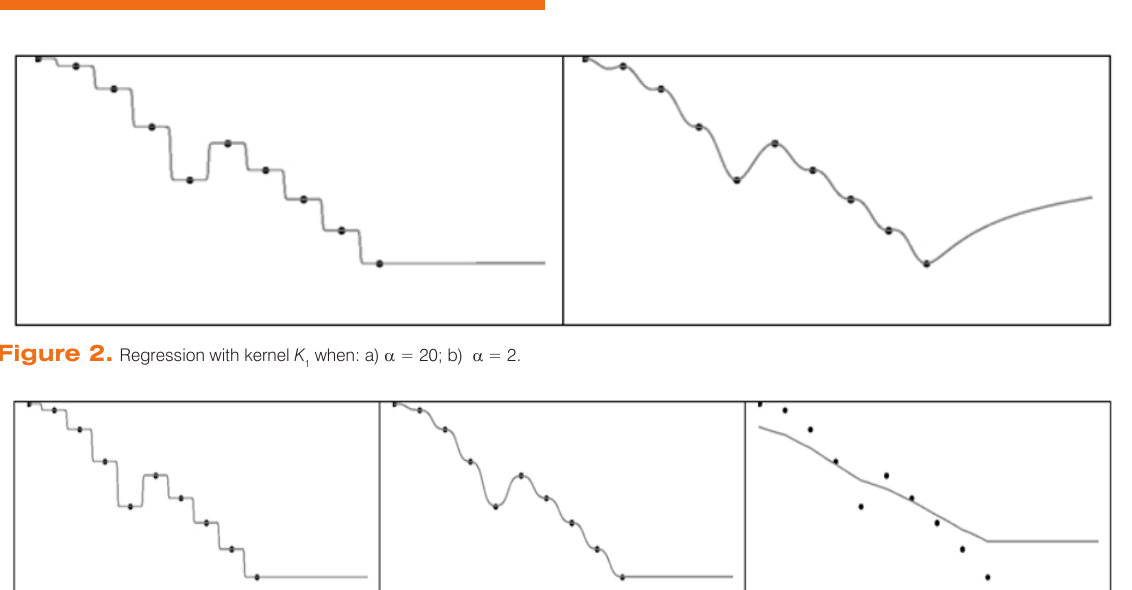
Figure 3. Regression with kernel K